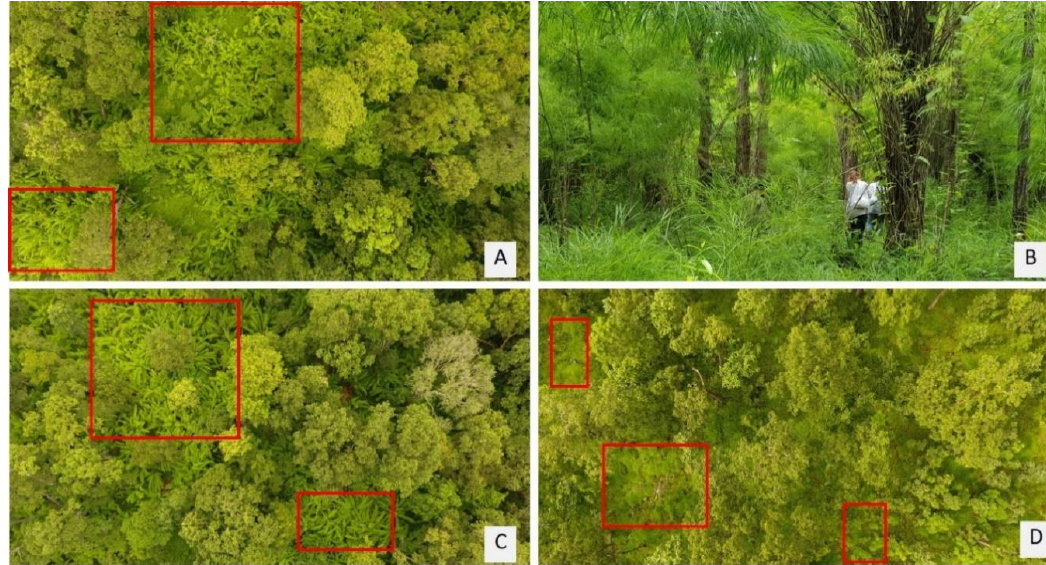
Figure 16. Images showing the locations of our field survey and unmanned aerial vehicle (UAV) Phantom 4’s captured locations for detecting bamboo. ( A ). evergreen forest and bamboo patches (red boxes outline bamboo distribution). ( B ). field survey of bamboo distribution along the river. ( C ). dense evergreen forest and bamboo distribution. ( D ). young bamboo patches in a deciduous forest.